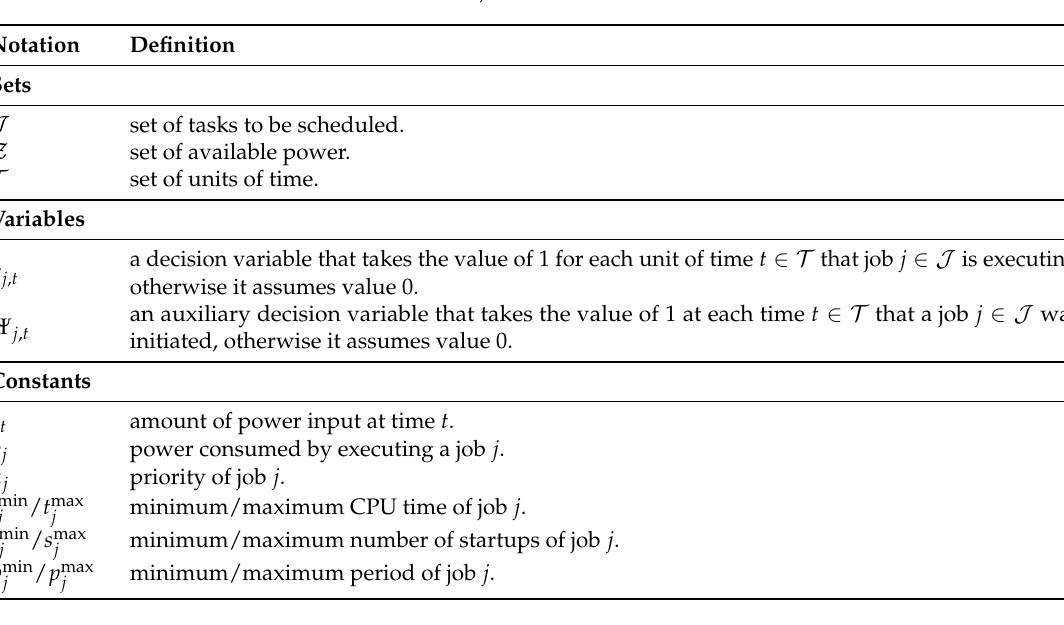
Table 3. Sets, variables and